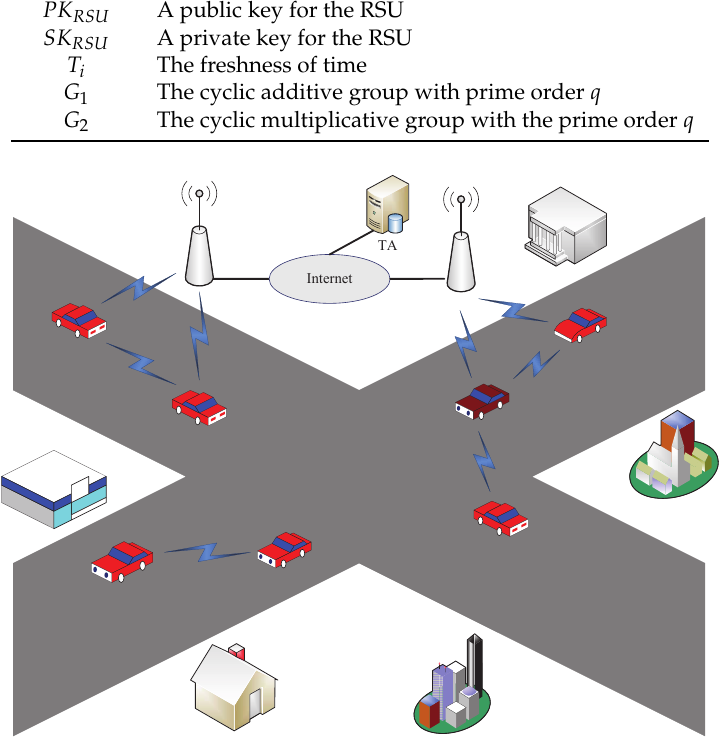
Figure 1. System